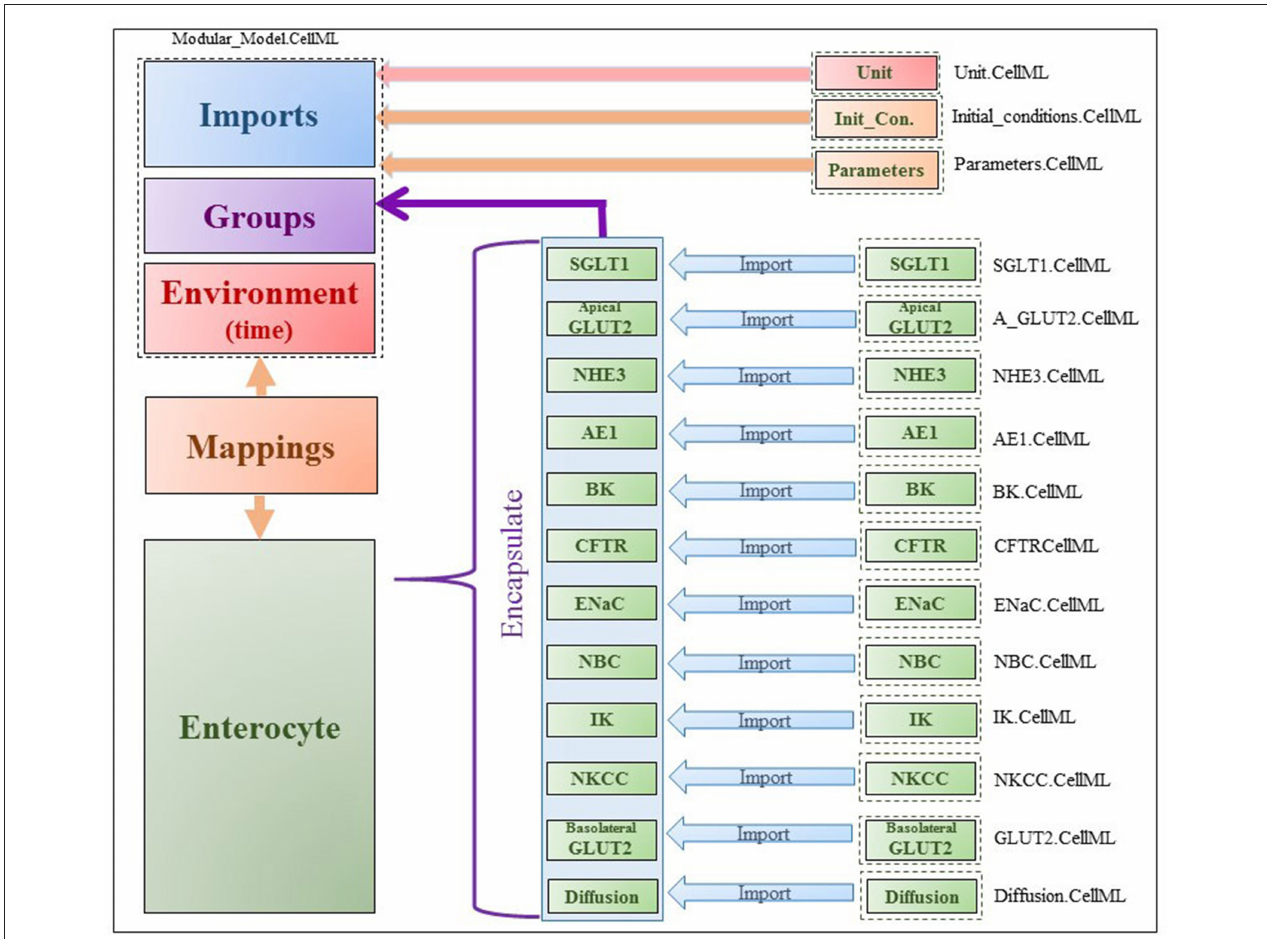
FIGURE 2 | Figure shows the modularity of CellML model. Encapsulation hierarchy (purple), the CellML model imports (blue) and the other key parts (units, parameters,components and mappings) of the top level CellML